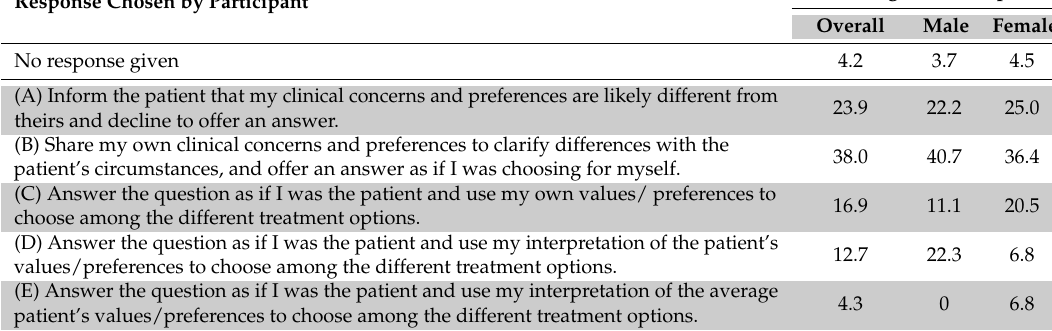
Table 3. Participants’ responses to Question 9: “Which of the following would best describe your response to an edentulous patient who in response to your advice about treatment options asks, “What